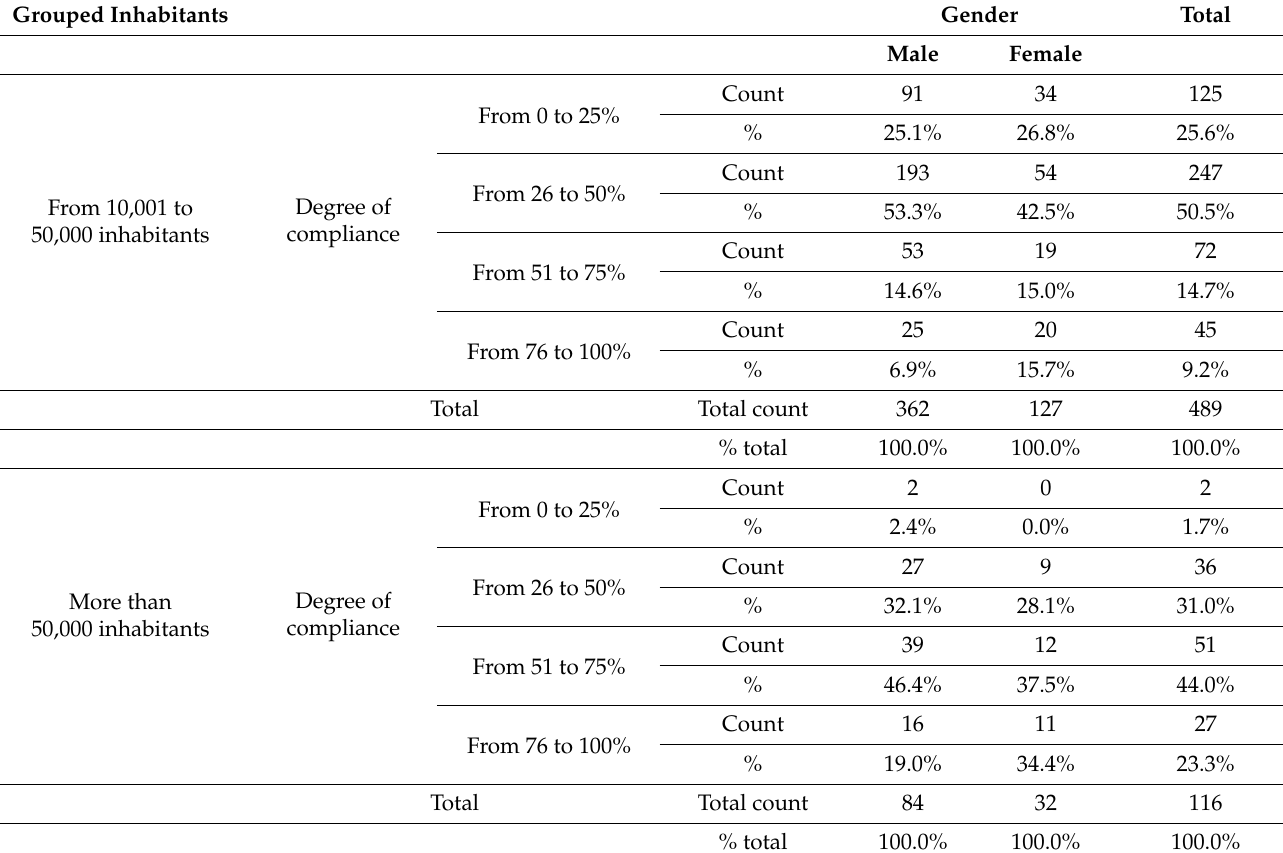
Table 5. Degree of compliance of indicators by